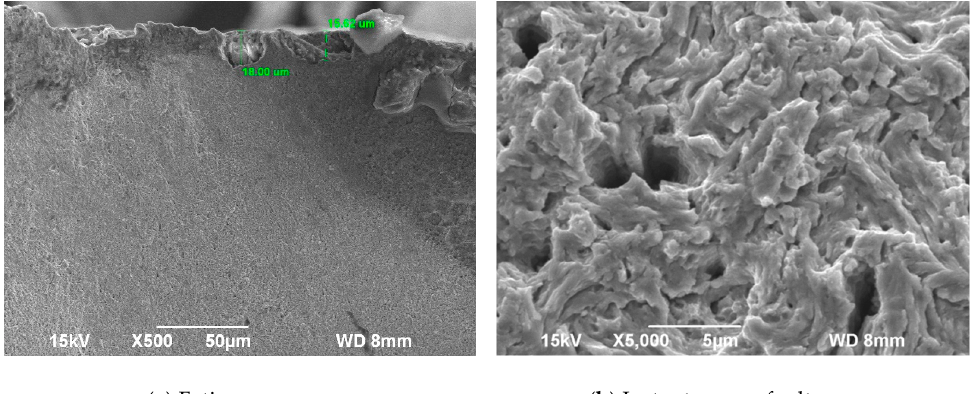
Figure 9. GJX12m fatigue fracture morphology.